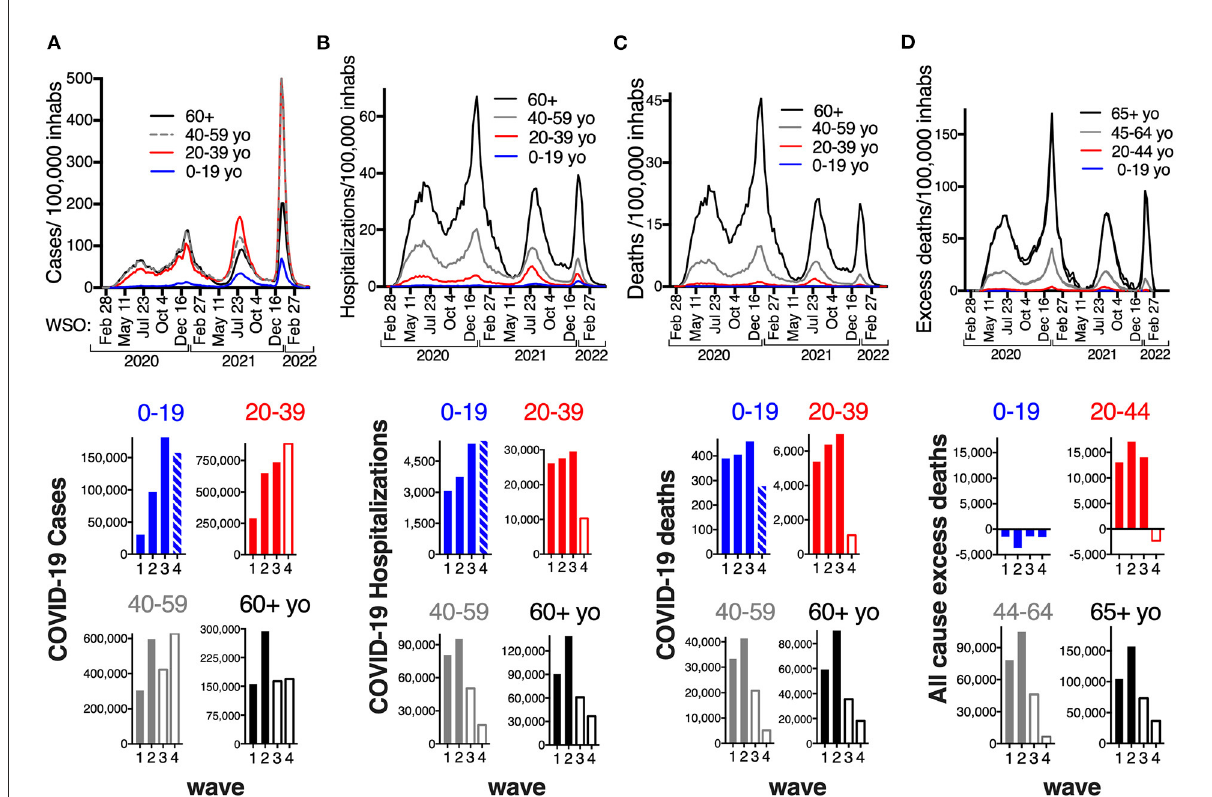
FIGURE2 Rates per 100,000 inhabitants of COVID-19 cases (A) , hospitalizations (B) , deaths (C) and all-cause excess deaths (D) , per epidemiological week of symptom onset (WSO), per age group (0–19 yo blue; 20–39 yo red; 40–59 yo gray; 60 + black), in the first 27 months of epidemic in Mexico (Feb 2020–April 2022). Bottom: Accumulated cases hospitalizations, deaths and all cause excess deaths, per wave per age group. Bars are empty when the age-group had access to COVID-19 vaccination. The last bar in age group 0–19 represents that 15–19 yo had access to vaccination but not the rest of the children, 15–17 yo accessed first doses in December 2021; while 18–19 yo were vaccinated with the adults beginning on late August 2021, thus had the chance to complete a primary series before the fourth (Omicron) wave.